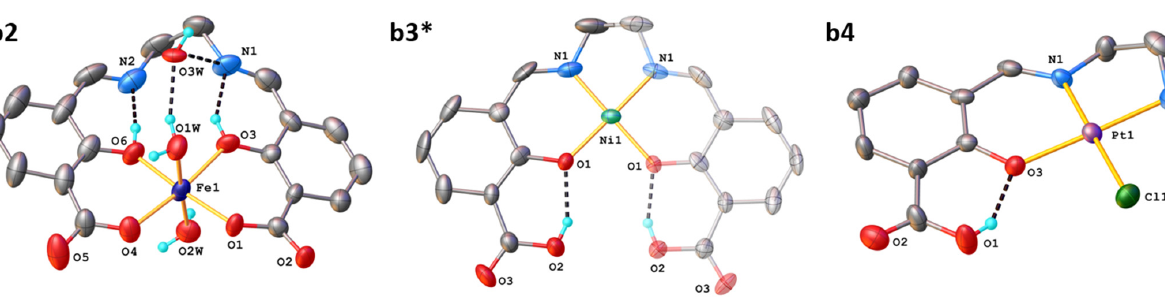
Products of the AEAMDS reaction with 3-fsa and metal salts.